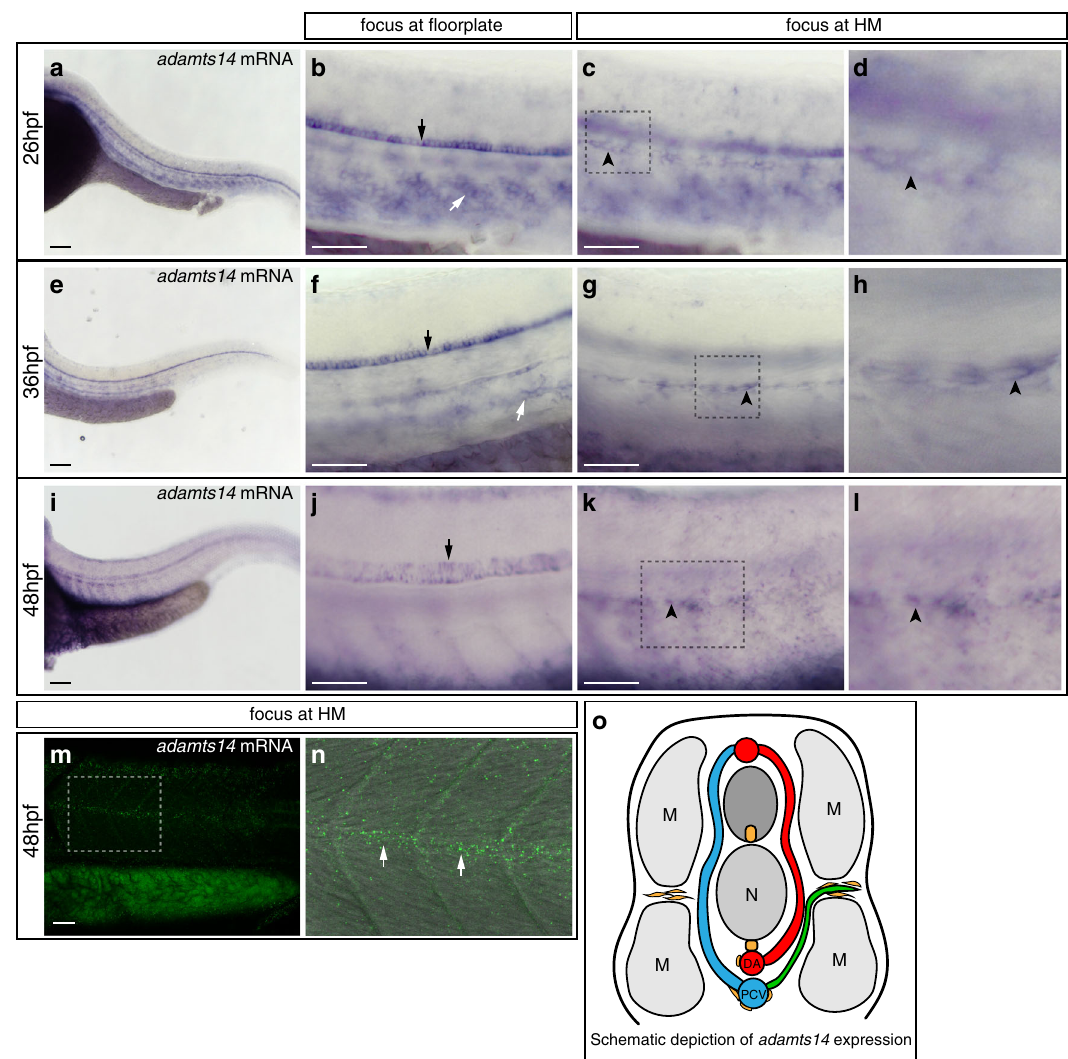
Fig. 4 adamts14 expression can be detected in the fl oorplate and at the horizontal myoseptum. a – l Whole mount in situ hybridization for adamts14 . a – d At 26hpf, adamts14 transcripts are detectable in the fl oorplate (black arrow), in cells along the ventral aspect of the segment boundaries (white arrow) and in cells at the HM (black arrowhead). d Zoom-in of the squared region in c . e – h At 36hpf, adamts14 expression is visible in the fl oorplate (black arrow), in cells located at the level of the axial blood vessels (white arrow) and in cells at the HM (black arrowhead). h Zoom-in of the indicated region in g . i – l Expression of adamts14 is still apparent in the fl oorplate (black arrow) at 48hpf as well as in cells at the HM (black arrowhead). l Enlargement of the boxed region in k . m , n adamts14 RNA granules can be detected in cells located in the HM region by RNAscope at 48hpf. n Overlay of the bright fi eld and confocal image for the indicated region in m , showing adamts14 RNA granules in green. o Schematic cross view of the trunk illustrating the adamts14 expression domains (yellow). Scale bars in a , e , i : 100 µ m; b , c , f , g , j , k , m : 50 µ m. DA dorsal aorta, hpf hours post fertilization, HM horizontal myoseptum, M muscle, N notochord, PCV posterior cardinal vein, PL parachordal